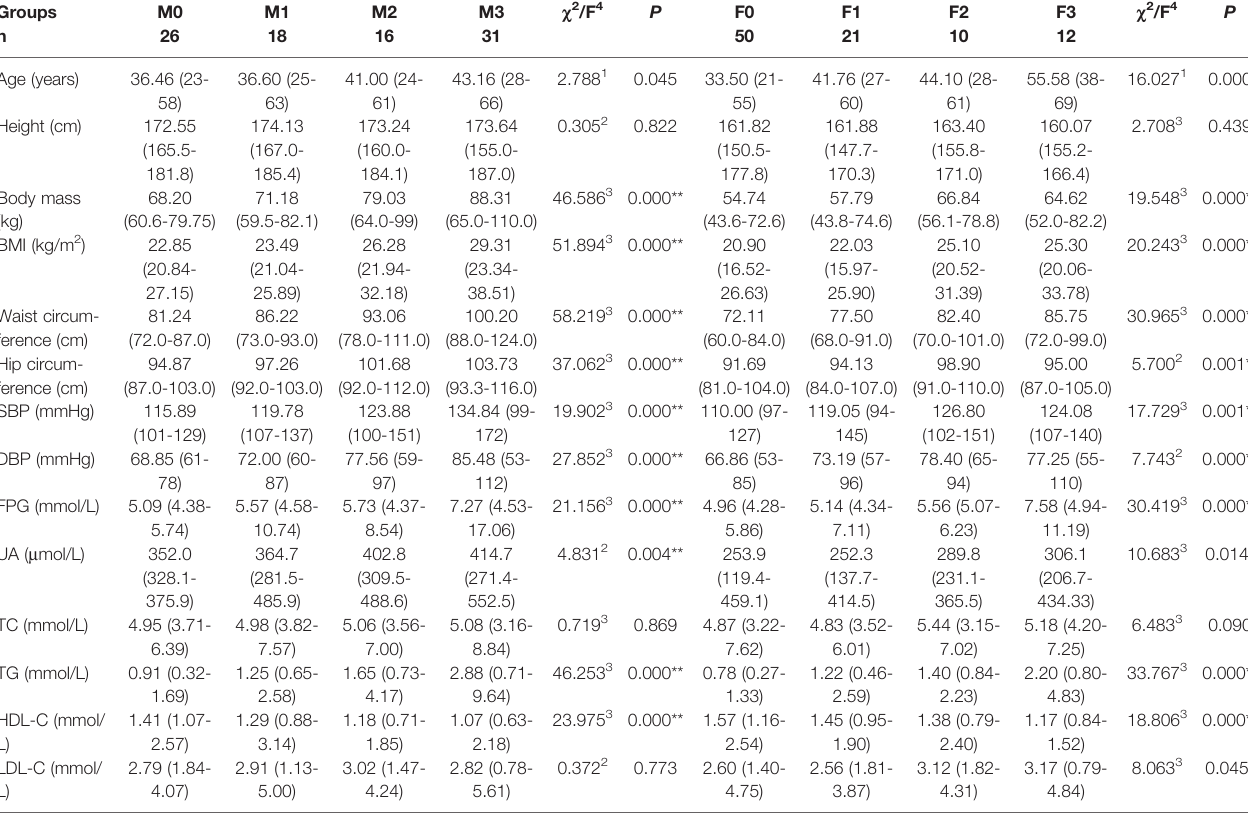
TABLE 1 | Baselines of age, measurement and laboratory data in groups (mean, minimum-maximum).